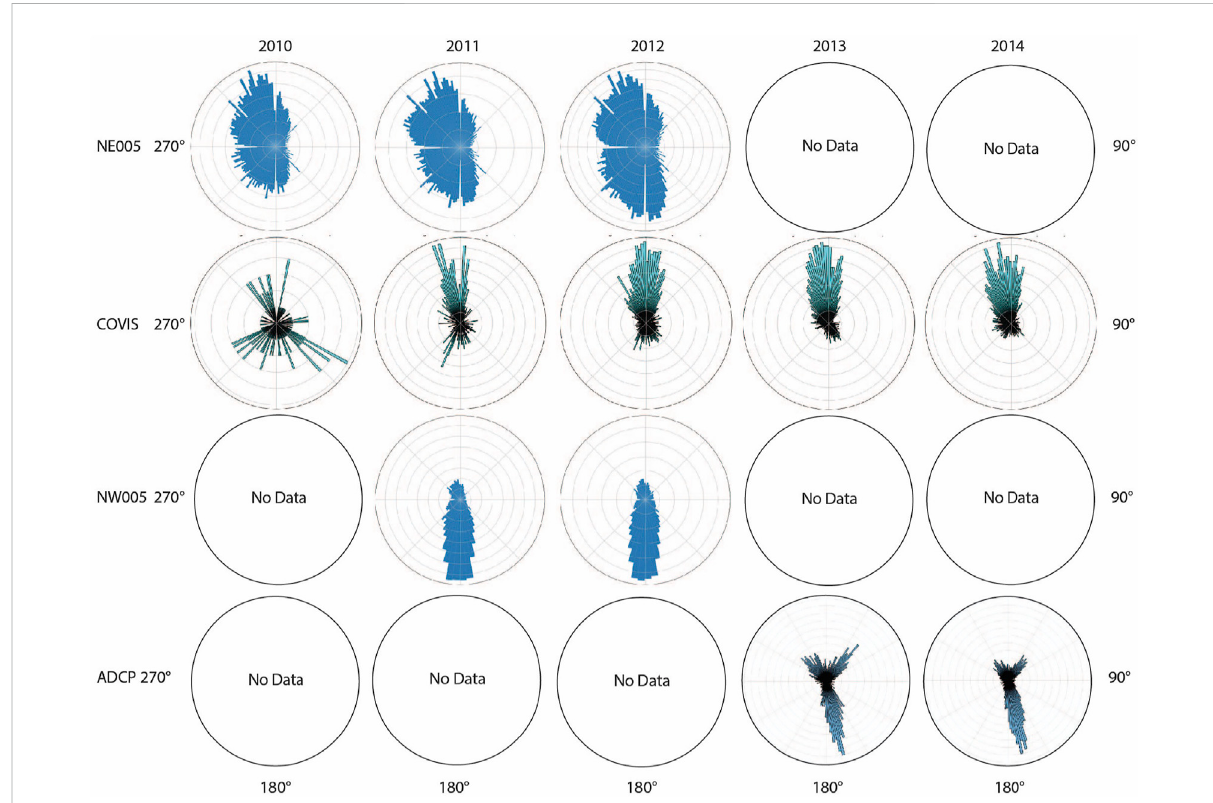
FIGURE 7 A simple model to illustrate plume response to steady currents. Plumes rise vertically in a stagnant ocean (C) but are de fl ected northwards by north- fl owing currents (D,E) or southward by south- fl owing currents (B,A) . Eastward de fl ection re fl ects the eastward component expected in the local oscillating tidal currents. The degree of de fl ection depends on the ratio of current speed to plume rise